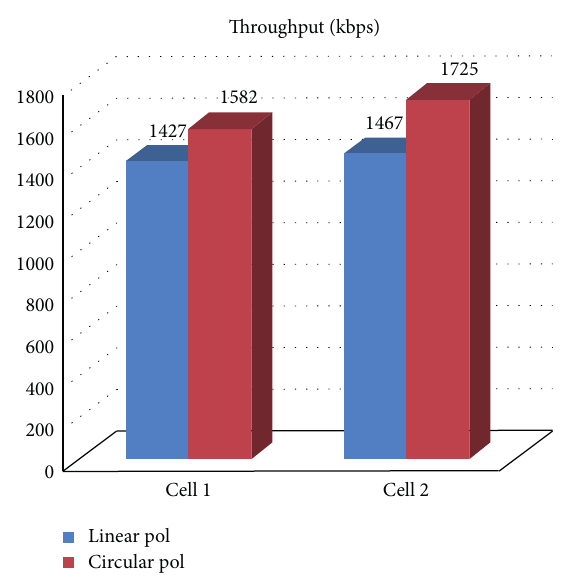
Figure 9: Test result of MIMO diversity improvement using circular polarized